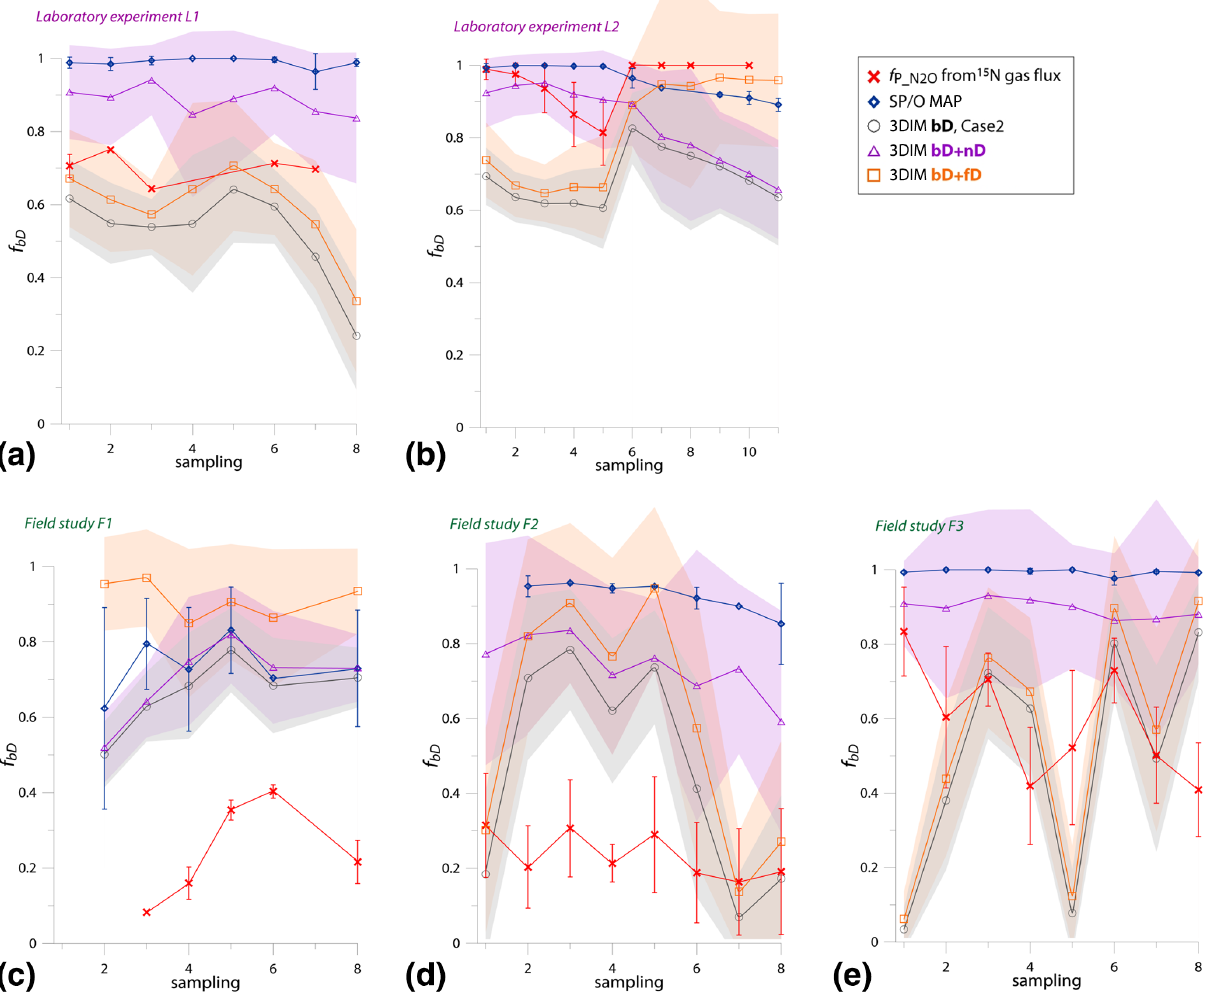
Figure 7. Comparison of N 2 O fractions comprising bacterial denitrification ( f bD ) determined with O / SP MAP Case 1 (representing bD + nD) and 3DIM Case 2 (respective fractions determined: bD, bD + nD, bD + fD) with the reference method ( 15 N gas flux). The 15 N gas-flux method determines the f P_N – 15 N-pool-derived fraction – comprising all N 2 O origins utilizing 15 N-labeled NO − 2 O mostly bD and fD. See Sect. 4.2 and 4.3 for further discussion. For 3DIM results, the 95% confidence interval is shown with shaded areas. Error bars for O / SP MAP and 15 N gas-flux data represent the standard deviation of replicate samples ( n =